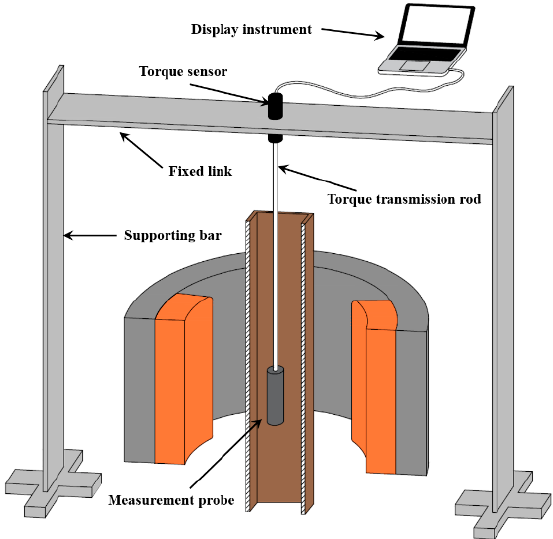
Figure 2. Schematic diagram of the electromagnetic torque measurement device.